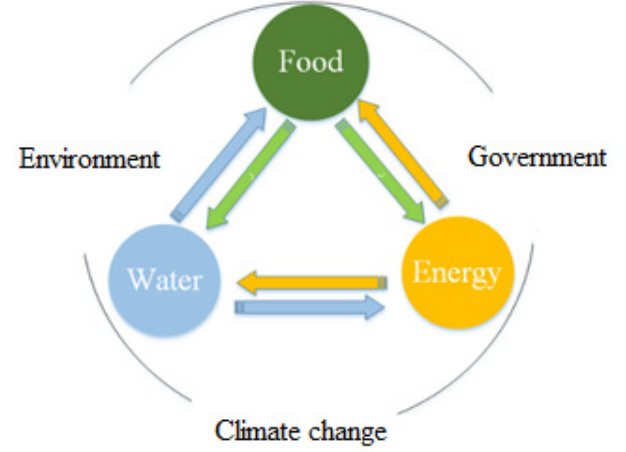
Figure 2. A conceptual model of food–energy–water (FEW) nexus.